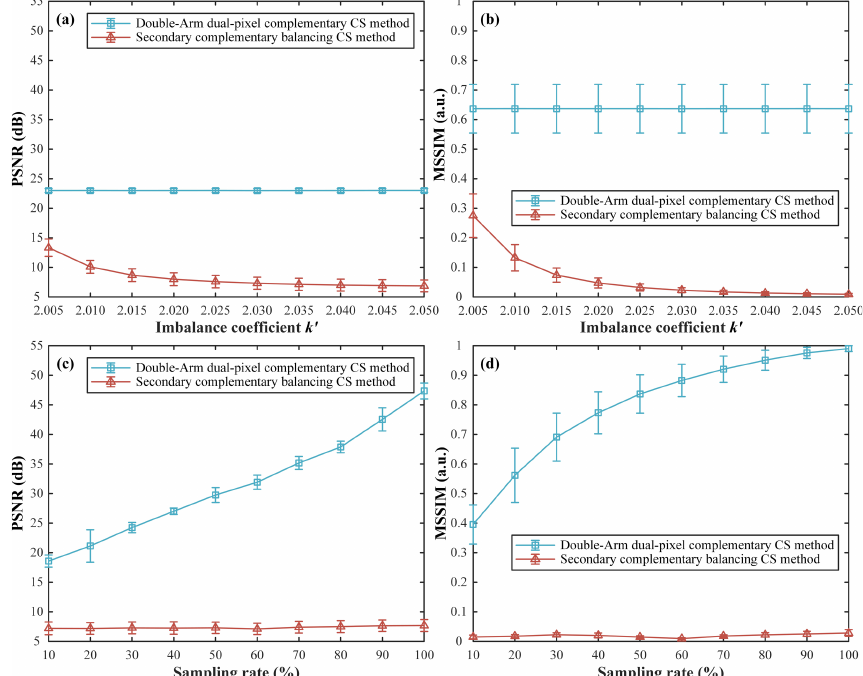
Figure 3. Comparisons of reconstructed results of several general scenes by using the double-arm dual-pixel complementary CS method and the secondary complementary balancing CS method.